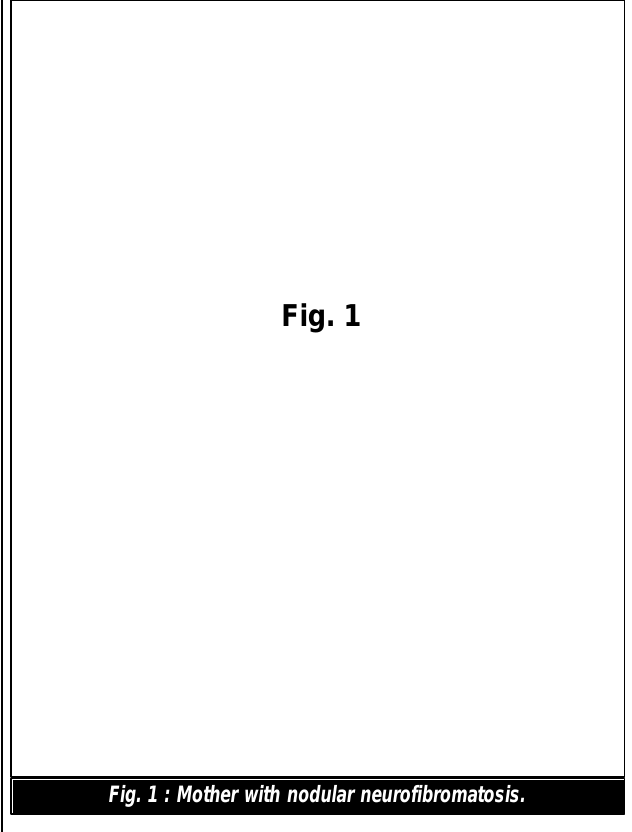
Fig. 1 : Mother with nodular neurofibromatosis.